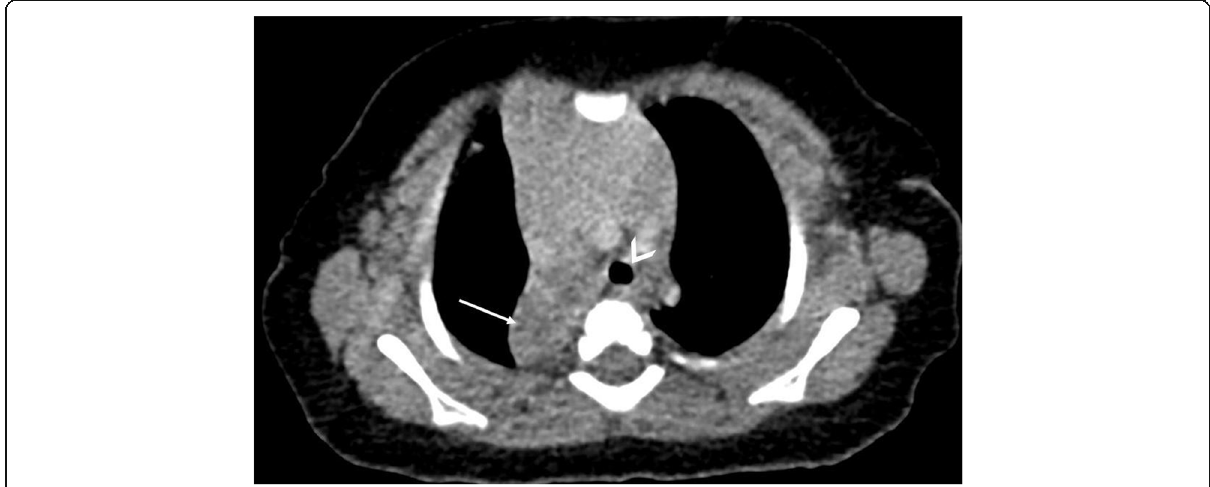
Fig. 3 Non-contrast-enhanced axial CT post-aspiration of the mediastinal mass shows significant improvement in the mass effect on the trachea (arrowhead) and thymus. The right upper posterior consolidation concerning pulmonary sequestration (arrow) remains